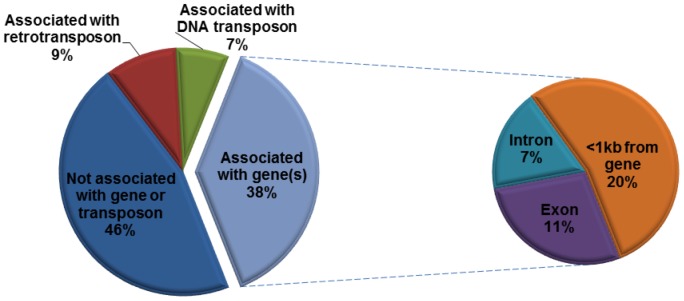
Association of PbTRIM with genes in the P. barbatus genome.Among a total of 243 complete elements, solo-LTRs and element fragments of PbTRIM family, 100 (38%) have overlap with gene exons and/or introns, or located within 1-kb from a predicted gene.